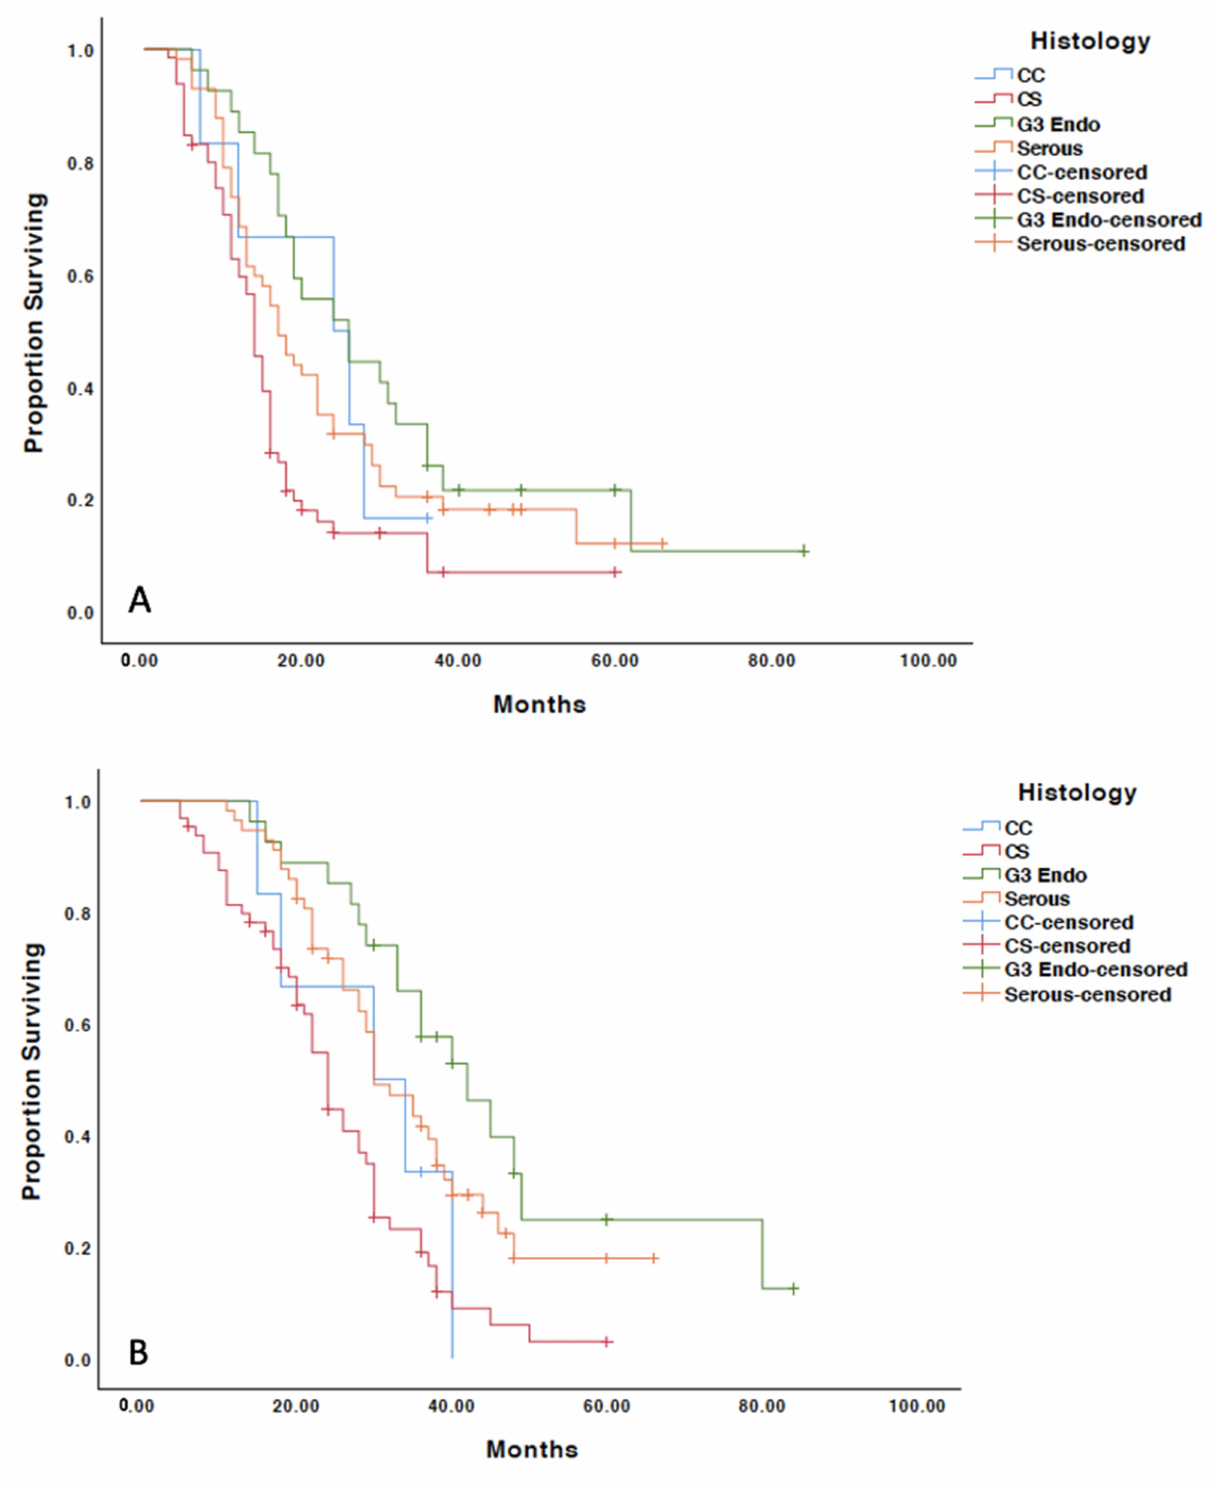
Figure 1. Kaplan–Meier survival analysis by histology. ( A ) Progression-free survival analysis; ( B ) overall survival analysis; CC: clear cell; CS: carcinosarcoma; G3 Endo: grade 3